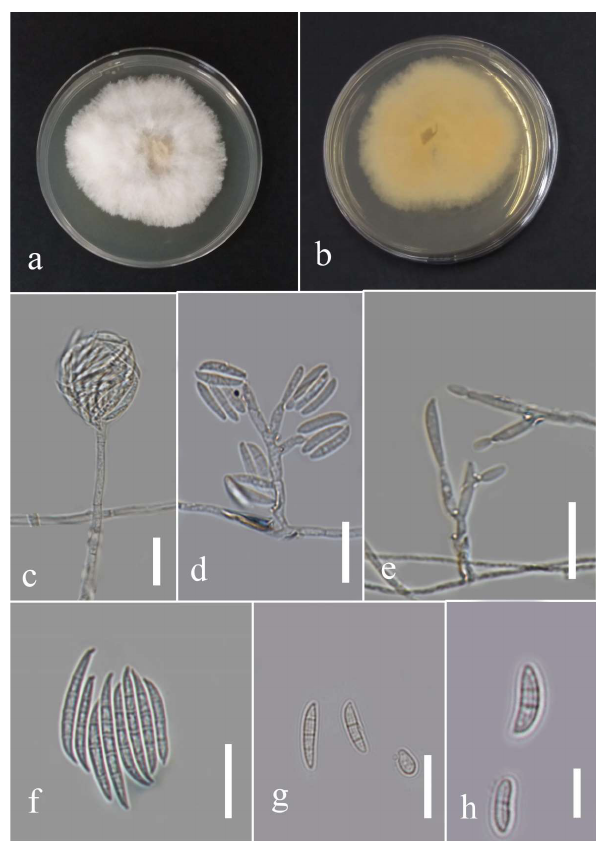
Figure 35. Morphology of Fusarium pernambucanum (MFLUCC 22-0148): ( a , b ) upper and reverse views of the culture after seven days of growth on PDA at 28 ◦ C; ( c ) false head; ( d , e ) phialides; ( f – h ) conidia. Scale bars ( c – g ) = 20 µ m and ( h ) = 10 µ m. Fusarium sulawesiense Maryani, Sand.-Den., L. Lombard, Kema & Crous, 2019. Facesoffungi number: FoF 13412; Figure